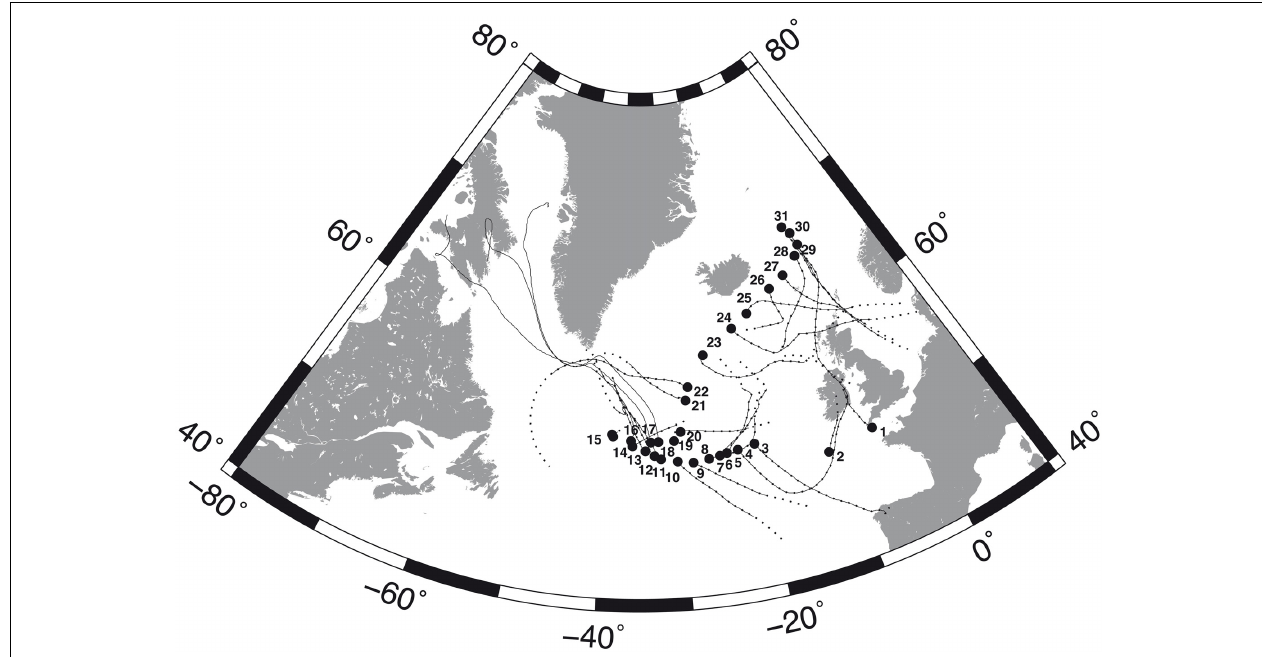
FIGURE 1 | Sampling sites (black circles) along the MEDEA-II cruise and forward trajectories of the air masses during the calculated time for remaining prokaryotic (continuous lines) and eukaryotic (broken lines) loads of